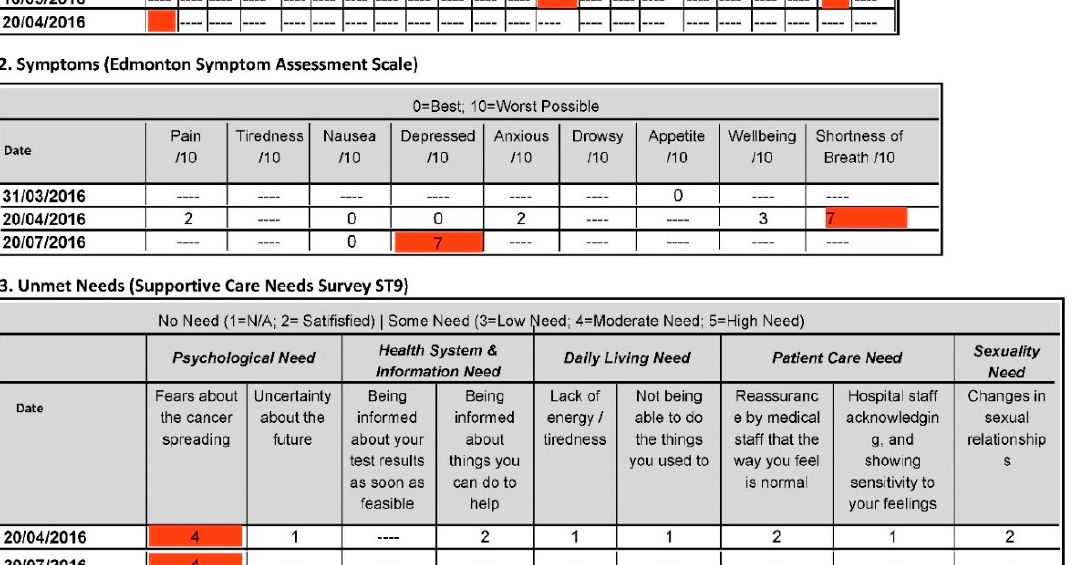
Figure 3. Sample longitudinal feedback report. Originally published in: [20].